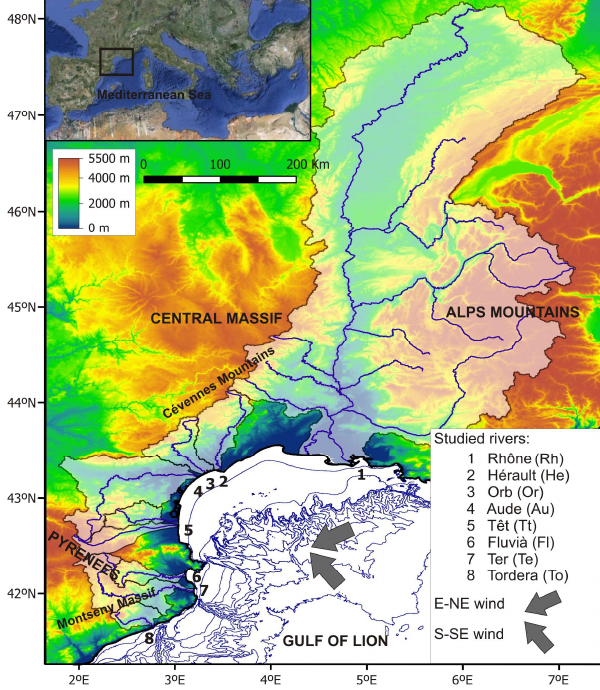
Figure 1. Location of the study area with the eight studied rivers and their watersheds, the 831 Fig. 1. Location of the study area with the eight studied rivers and orography and the main wind directions. 832 their watersheds, the orography and the main wind